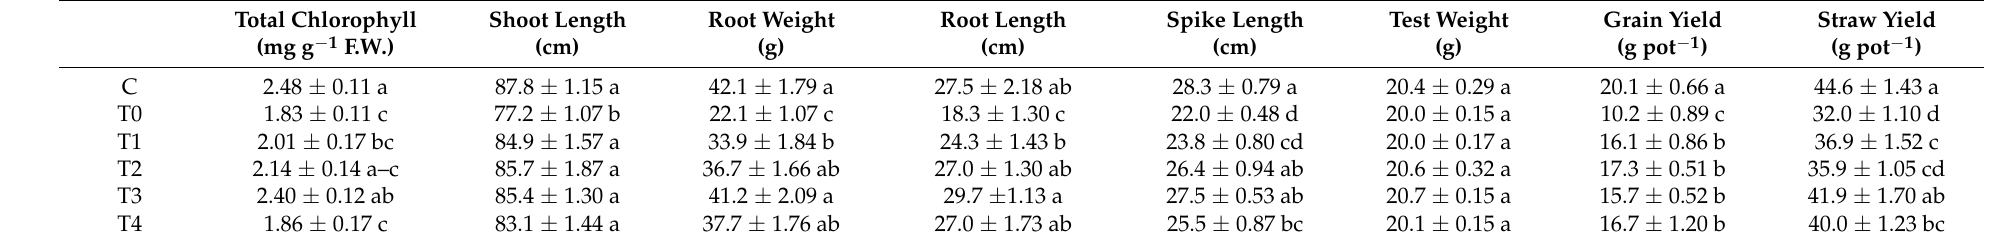
Table 1. Effect of arsenic (As) and combined As and orthphosphate (P) treatments on agronomic parameters of rice ( Oryza sativa L.). Treatments, C and T0, indicate untreated control, and 10 mg kg − 1 As treated group, respectively. The base soil As content in control group was 35 µ g kg − 1 . T1, T2, T3, and T4 denote combined treatments, 10 mg kg − 1 As + 10 mg kg − 1 P, replicates. Significant differences ( p < 0.05) among different treatments are shown by different